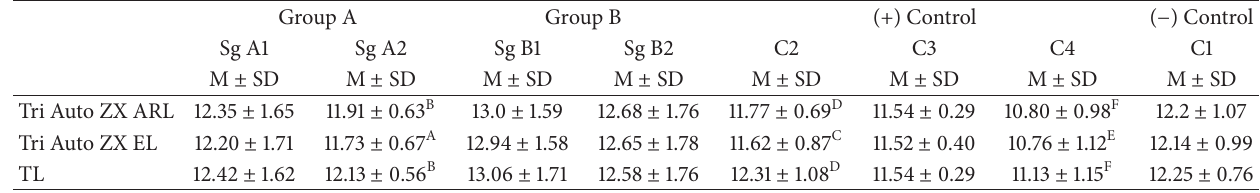
Table 2: Sg: subgroup, M: mean, SD: standard deviation; subgroups’ evaluations were done according to three different parameters (Tri Auto